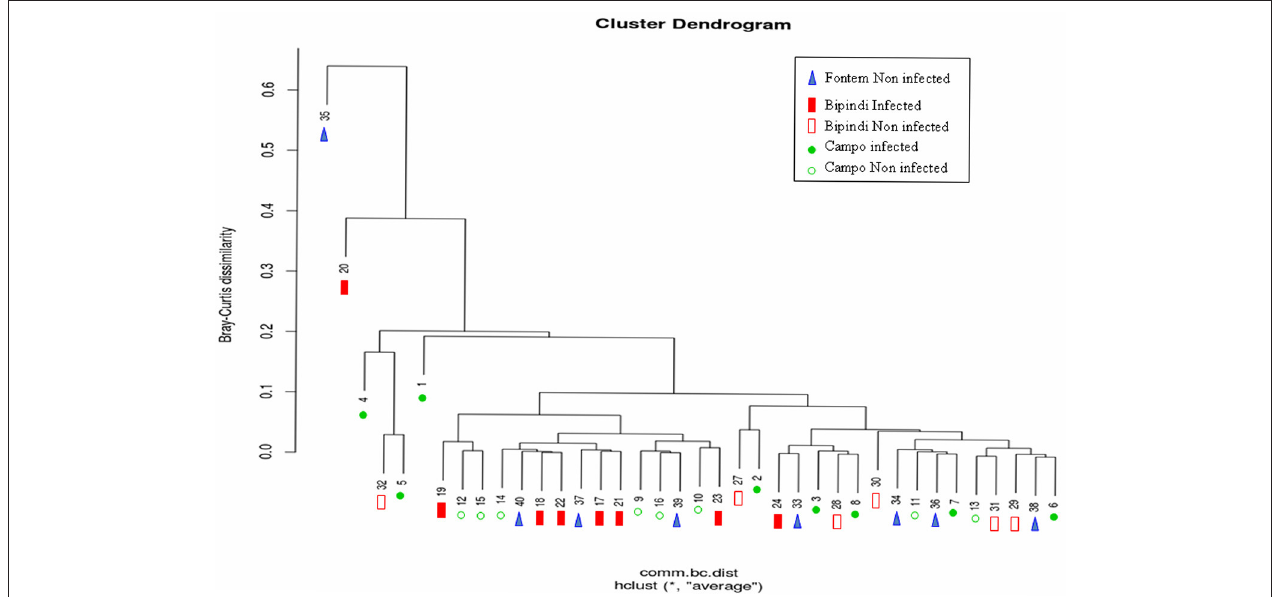
FIGURE 6 | Hierarchical cluster dendrogram based on Bray-Curtis Index values, showing the relationship between different samples (represented by numbers) and foci. Sample numbering as in Figure 4 .